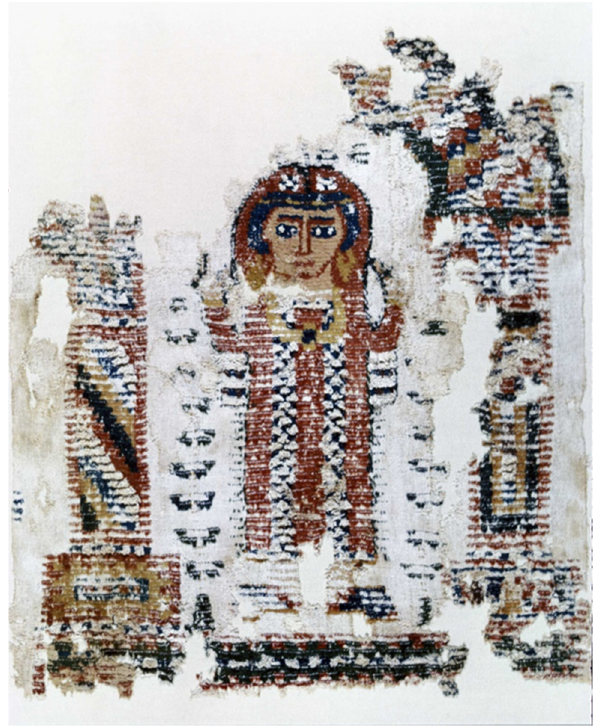
Figure 17. Curtain Panel , possibly 5th century CE. Coptic; Egyptian. Linen and wool; 69.9 × 63.5 × 50.2 cm (27 1/2 × 25 × 19 3/4 in.). Detroit Institute of Arts, Founders Society Purchase, Octavia W. Bates Fund, 46.75.